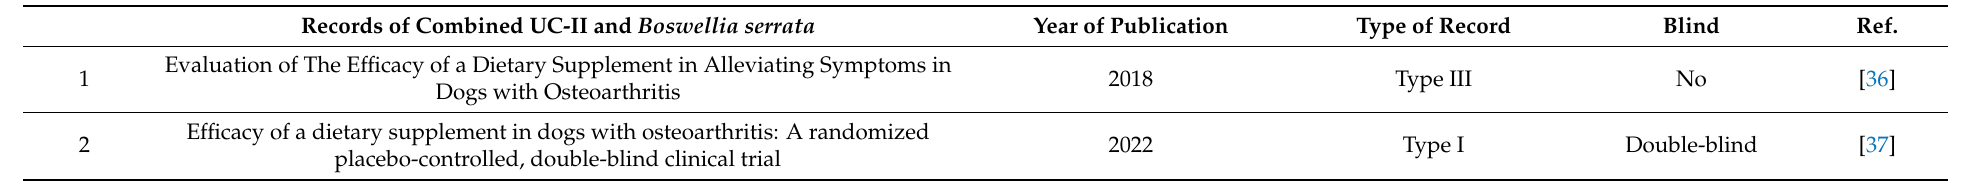
Table 4. Records included in the review based on the search performed regarding the combination of undenatured type II collagen and Boswellia serrata for managing clinical signs of osteoarthritis and joint support in